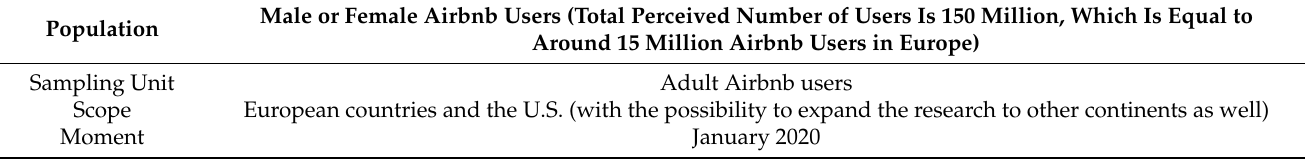
Table 1. Characteristics of the